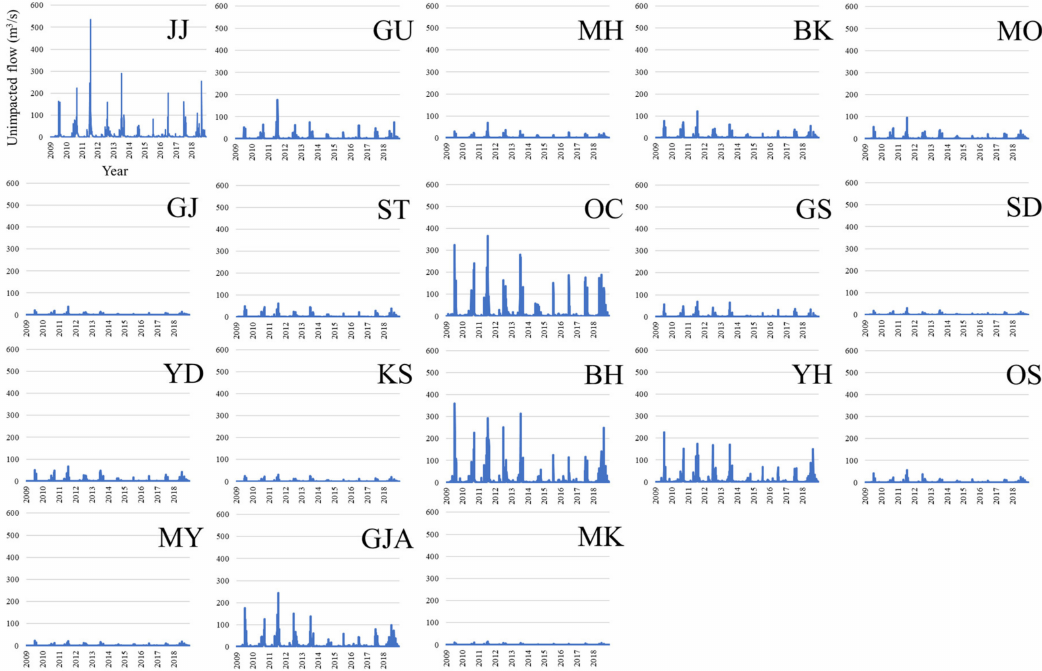
Figure 5. Simulated unimpacted flow by SMS-Tank model.